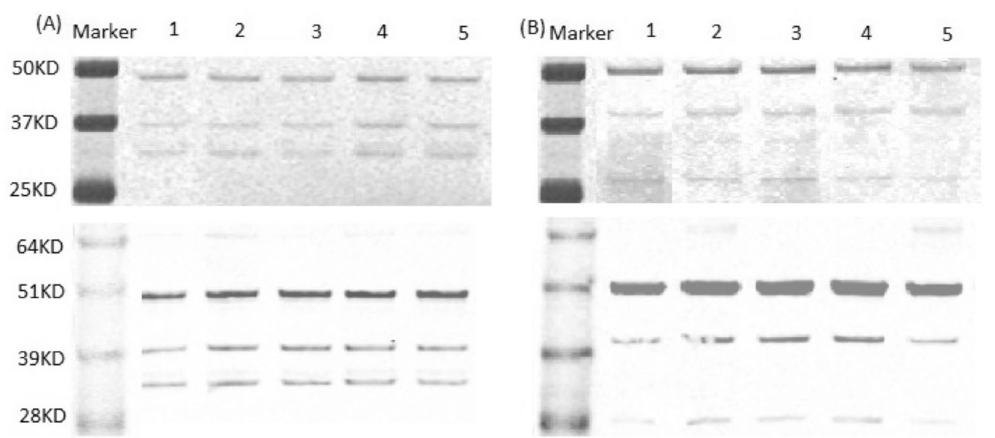
Figure 4. The results of SDS-PAGE gel (top) and Western blot (bottom) analysis of GI.1 VLPs ( A ) and GII.4 VLPs ( B ) after CDots treatments. Lane 1: VLPs control; Lane 2, 3: VLPs treated with 20 µ g/mL of EDA- CDots and EPA-CDots, respectively; Lane 4, 5: VLPs treated with 60 µ g/mL of EDA-CDots, and EPA-CDots,